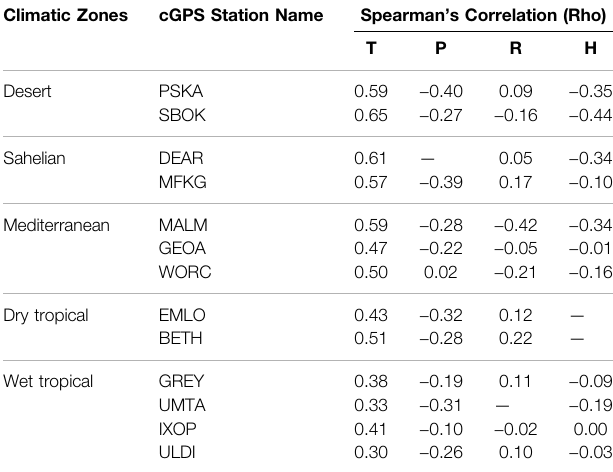
TABLE 3 | Displacement time series correlation values with atmospheric temperature (T), atmospheric pressure (P), rainfall (R), and humidity (H) time series at the selected stations in southern Africa. Climatic